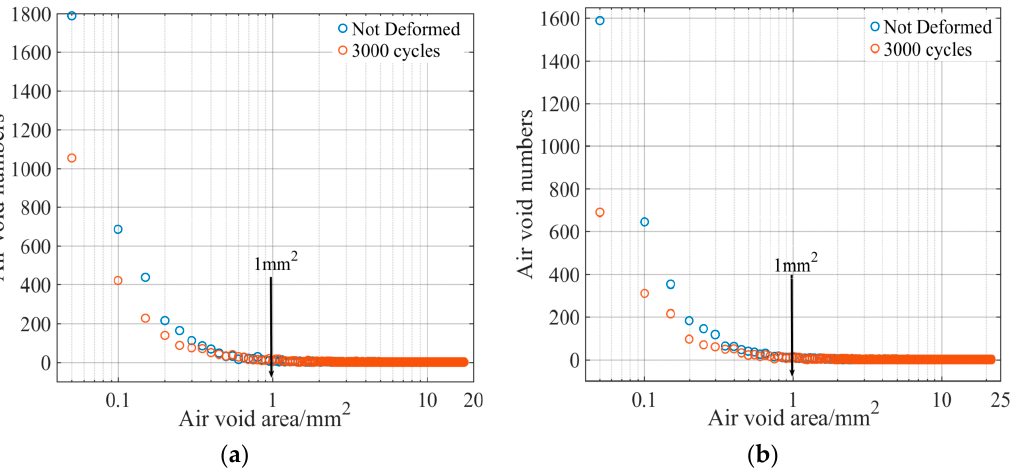
Figure 18. Relationship between air voids and corresponding quantities: ( a ) AC-13; ( b ) AC-16.